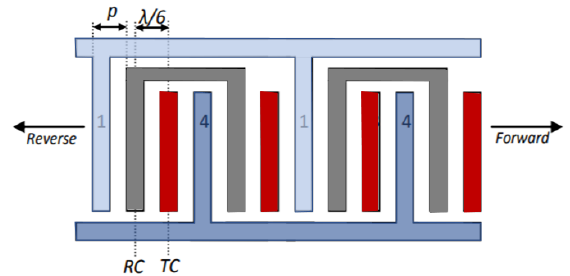
Figure 14. Schematic representation of the FEUDT electrodes configuration, where electrodes are numbered, 1, 2, 3, 4 designated by light blue, grey, red and dark blue colors, respectively in FEUDT layout [2].